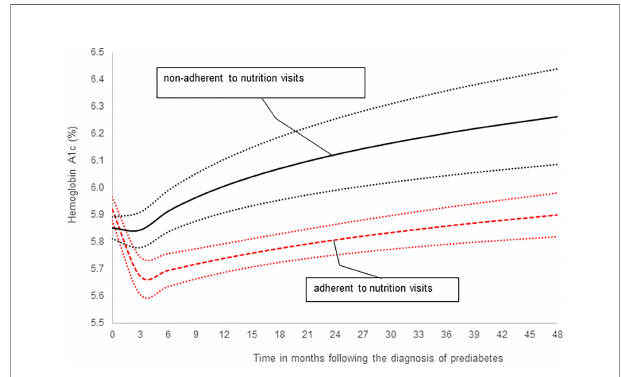
FIGURE 2 | A comparison of hemoglobin A1c trends strati fi ed by adherence to nutrition visits showing that the signi fi cant difference in HbA1c trends between the two groups persisted after adjusting for covariates: age, sex, race/ethnicity, BMI z-scores and metformin use ( Table 3 ,